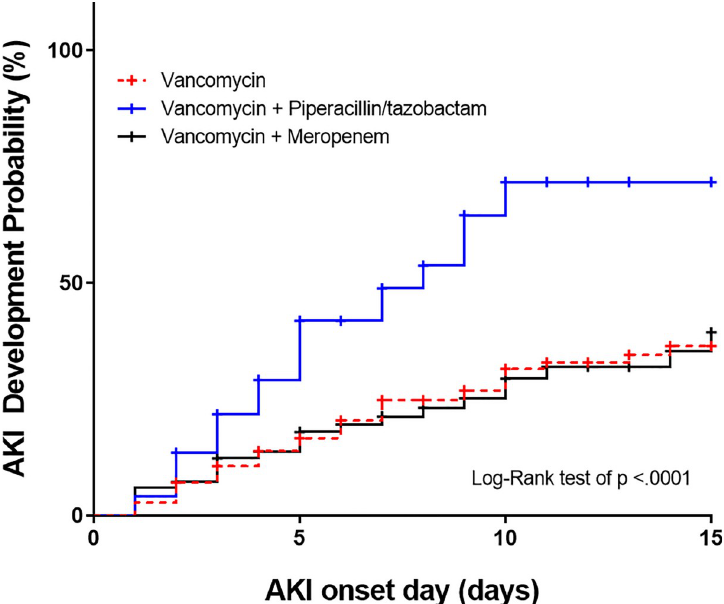
Fig 1. AKI development probability graph according to the survival analysis and log-rank test. Dotted red line marked indicates vancomycin monotherapy; continuous blue line indicates vancomycin plus piperacillin-tazobactam combination therapy; continuous black line represents vancomycin plus meropenem combination therapy; censored events were marked with crosses. https://doi.org/10.1371/journal.pone.0217908.g001 the APACHE II scores, antibiotic treatment groups, sepsis status, and use of norepinephrine. The final model of the multivariate logistic regression is shown in Table 4. The area under the curve was 0.741, and the p-value of Hosmer–Lemeshow test was 0.659, which means this model fitted well. Risk factors that significantly affected the AKI development were sex, use of combination therapy of VAN plus TZP, sepsis, and use of norepinephrine (Table 4). The odds of AKI in VAN + TZP were significantly higher than VAN, but not between VAN + MEM and